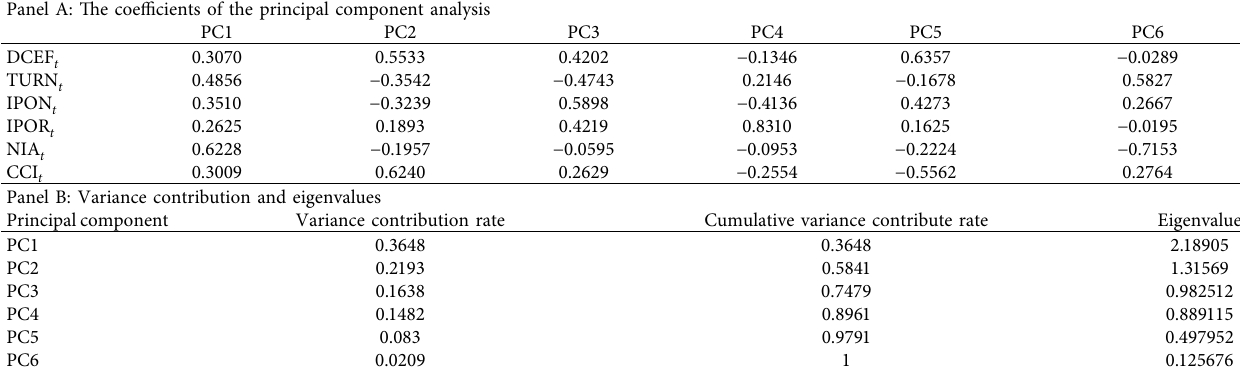
Table 1: Principal component analysis. Panel A: The coefficients of the principal component analysis PC1